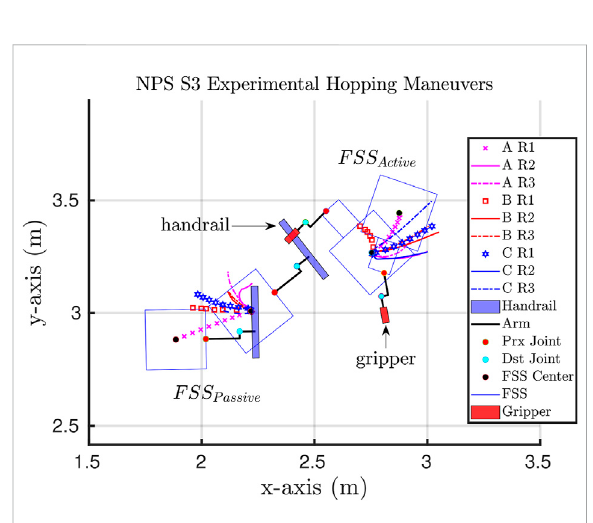
FIGURE 5 Illustration of ground experiments at NPS SRL, with the FSS Active grasping onto the handrail held by the FSS Passive as the initial start